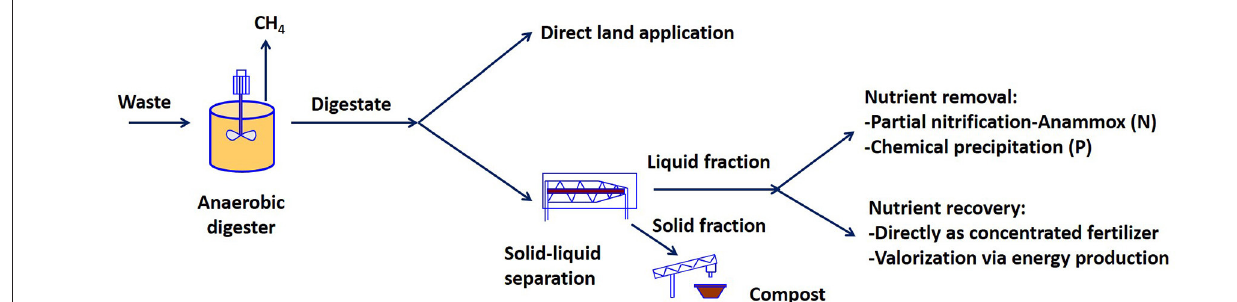
FIGURE 1 | Management options for digestates.